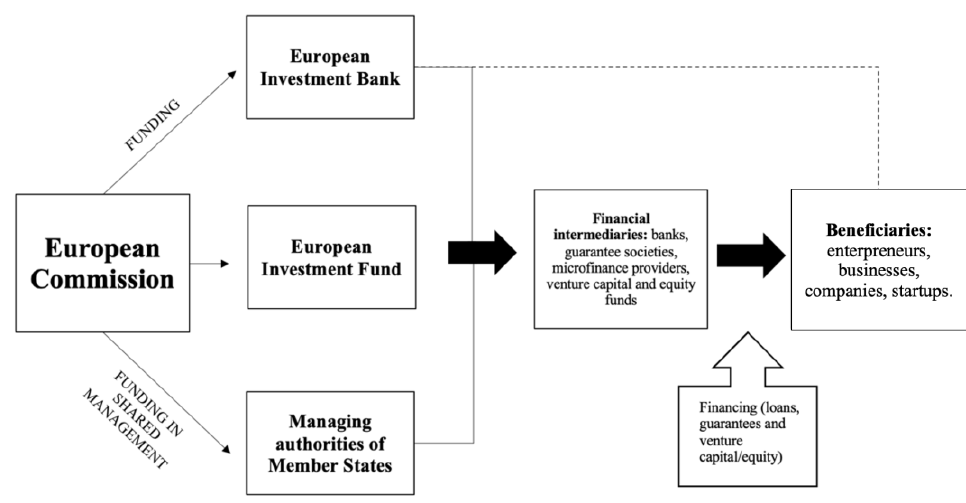
Figure 6. The scheme of financial support by EU Institutions. Source: Authors ’ compilation.